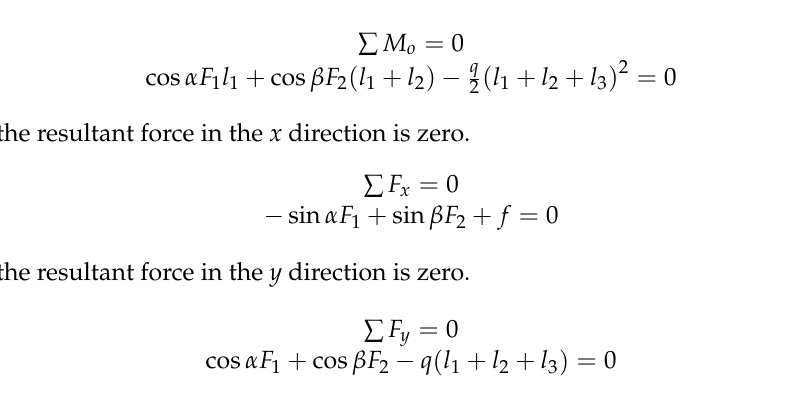
Figure 5. Mechanical model of the top beam of the top-coal caving hydraulic support. The equation is constructed from the equilibrium state of the support.